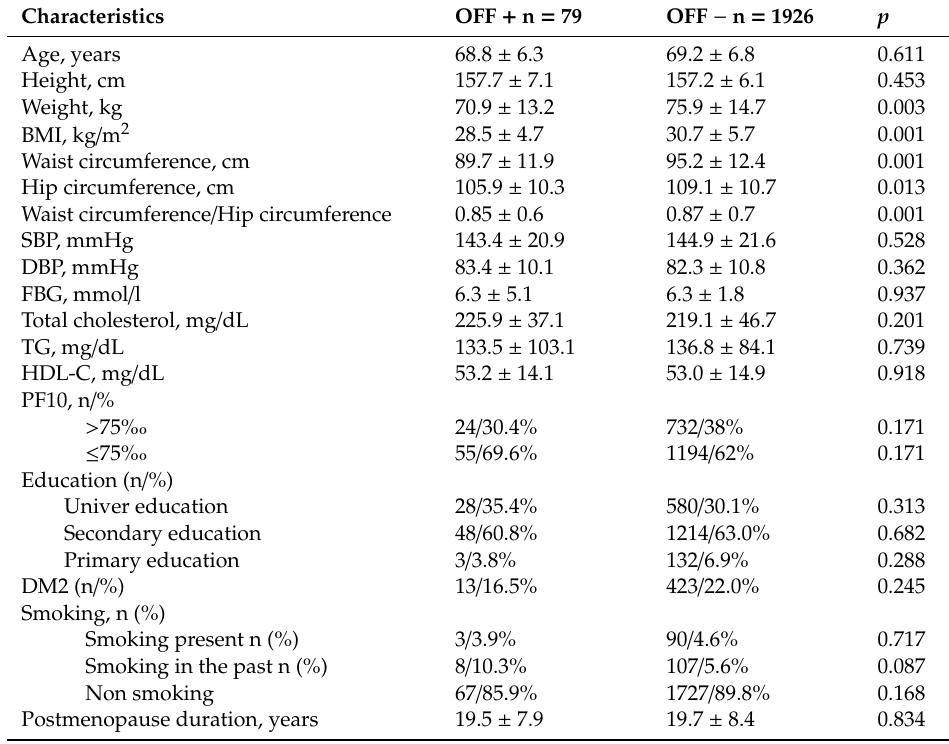
Table A1. Characteristics in groups of postmenopausal women aged 55–80 years with a history of OFF over the past 3 years and without a history of OFF.